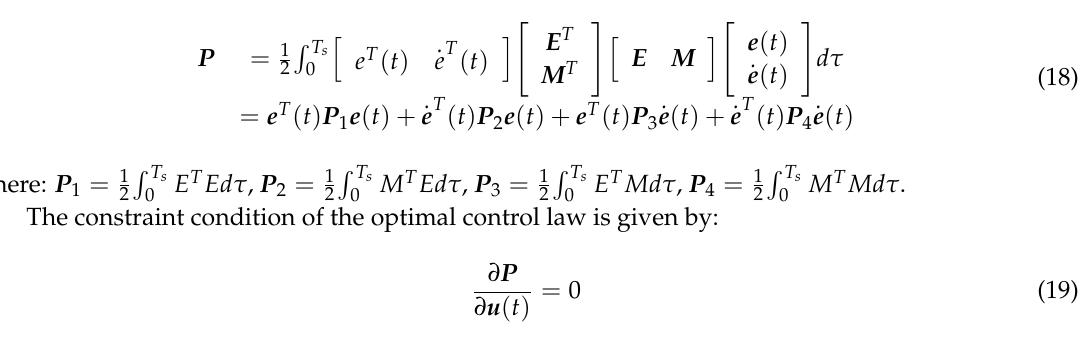
RNPCC Figure 3. Block diagram of the RNPCC method with composite integral terminal sliding mode observer (SMO) for permanent magnet synchronous motor (PMSM). 5. Design of the Composite Integral Terminal SMO